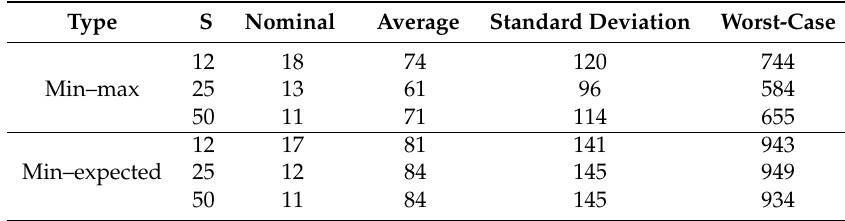
Table 4. Robust performance of min–max NMPC with different numbers of optimization scenarios from Bayesian inference evaluated using 100